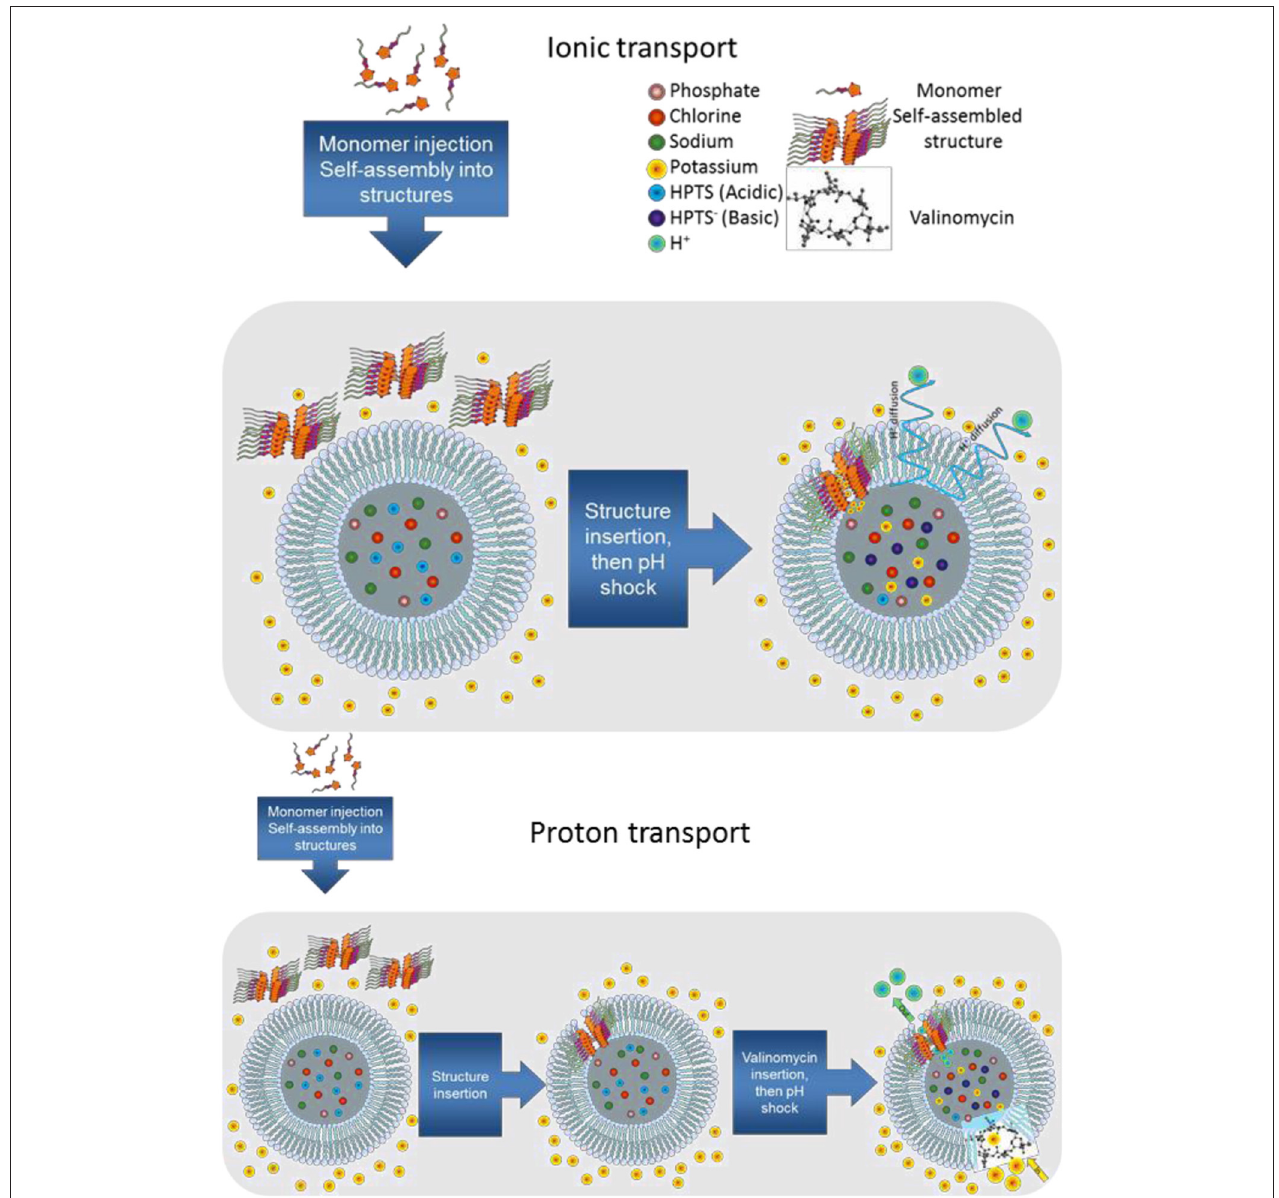
FIGURE 2 | Schematic representations of ionic and proton HPTS transport